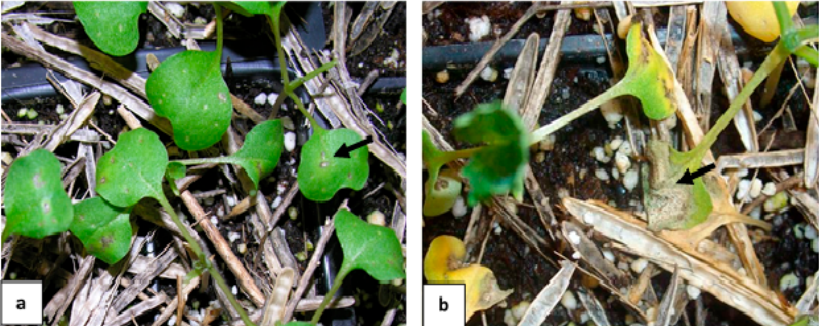
Figure 4. Reactions of Westar seedlings to inoculum produced by admixture. Arrows indicate ( a ) lesions starting to form seven days after wounding, and ( b ) advanced tissue collapse accompanied by pycnidia formation 14 days after wounding.